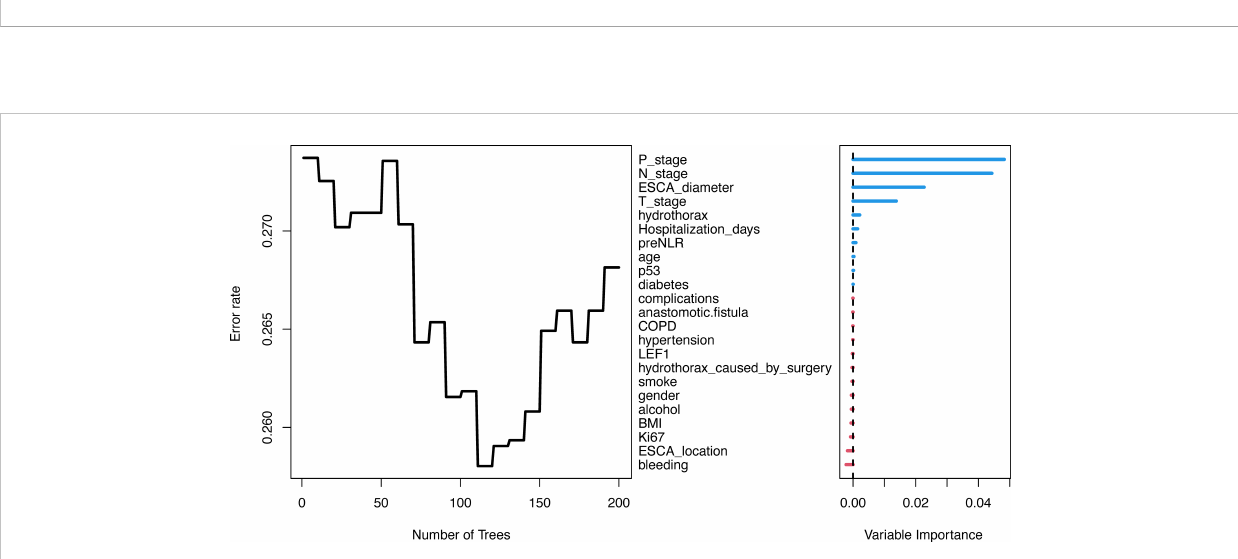
FIGURE 3 Randomforest regression. Variable importance rank by Randomforest